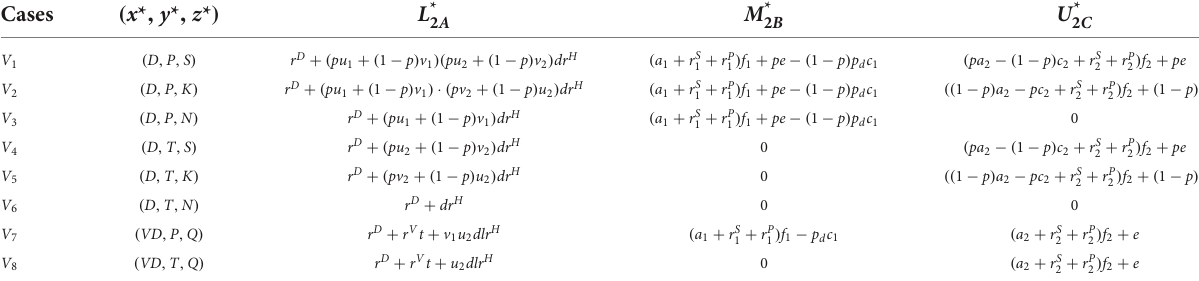
TABLE 4 Equilibrium values of the rumor verification